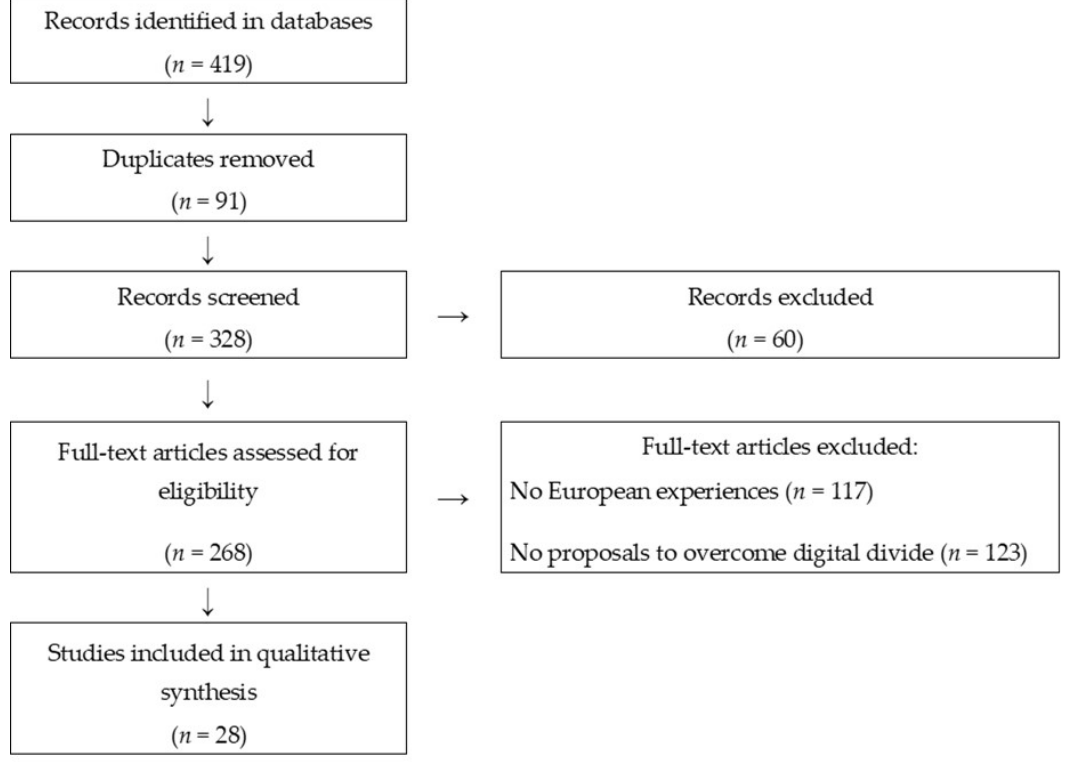
Figure 1. Flowchart of inclusion decisions. Source: The Authors from PRISMA standard.